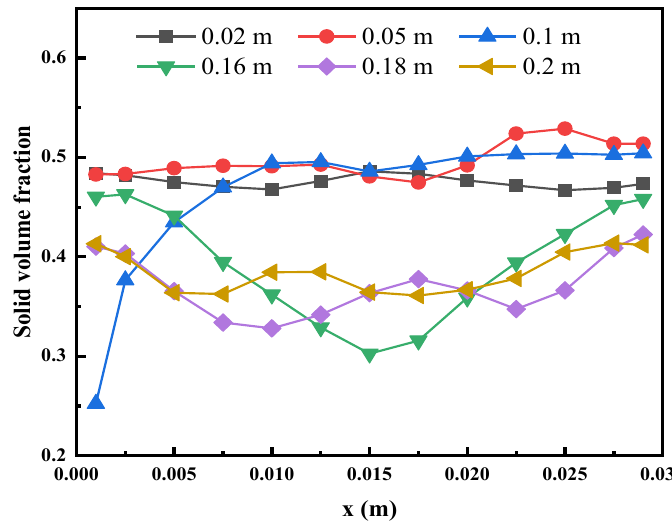
Figure 6. Radial distribution of time-averaged solid volume fraction at different bed heights.